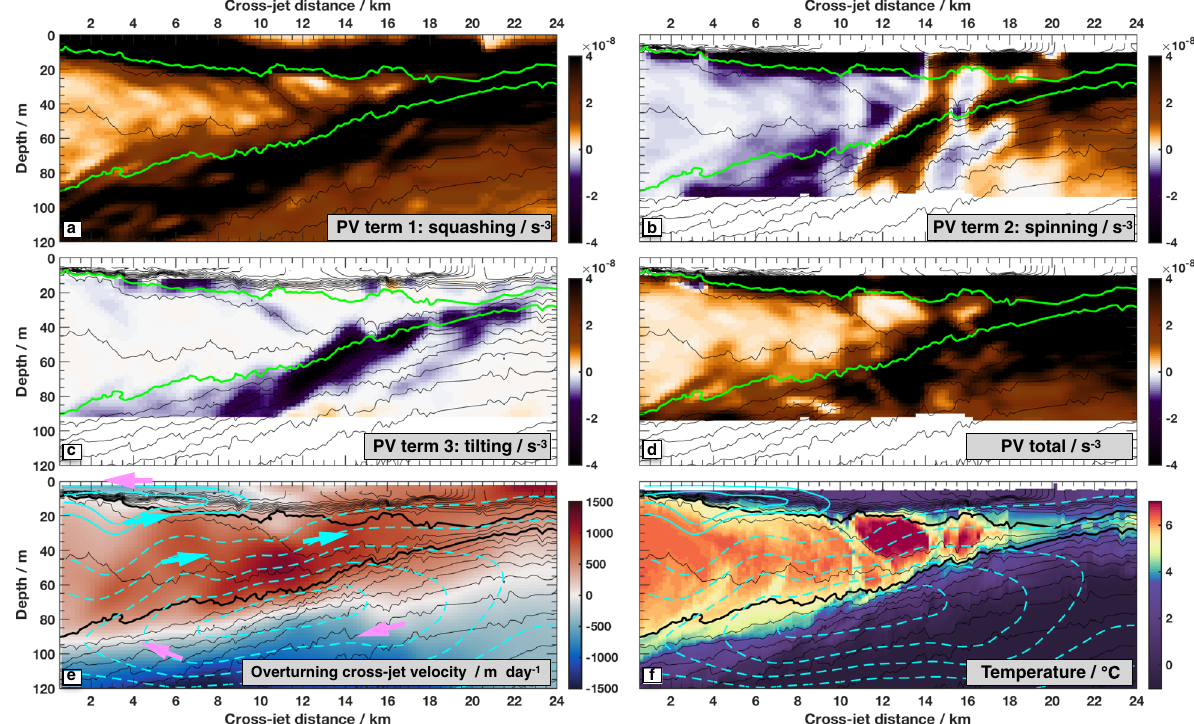
Fig. 4 Additional calculations for the section shown in Fig. 2. On all panels, isopycnals are contoured every 0.2 kg m 3 (thin black lines), with the 23.2 and 25.2 isopcynals in bold green or black. Color shading in each panel represents a the squashing (or stretching) component of potential vorticity (see Methods, where positive values indicate squashing with isopycnals spaced closer together); b the relative vorticity (spinning) component of potential vorticity; c the tilting component of potential vorticity; d the sum of all three potential vorticity components; e calculated overturning stream function from the omega equation ( Ψ , see “ Methods ” ), contours plotted from − 0.5 to 0 m 2 s − 1 with 0.1 increment (dashed) and 0 to 0.05 m 2 s − 1 (solid) with 0.02 increment, arrows indicate the direction of each overturning cell; f Temperature with the same overturning streamfunction contours as in e